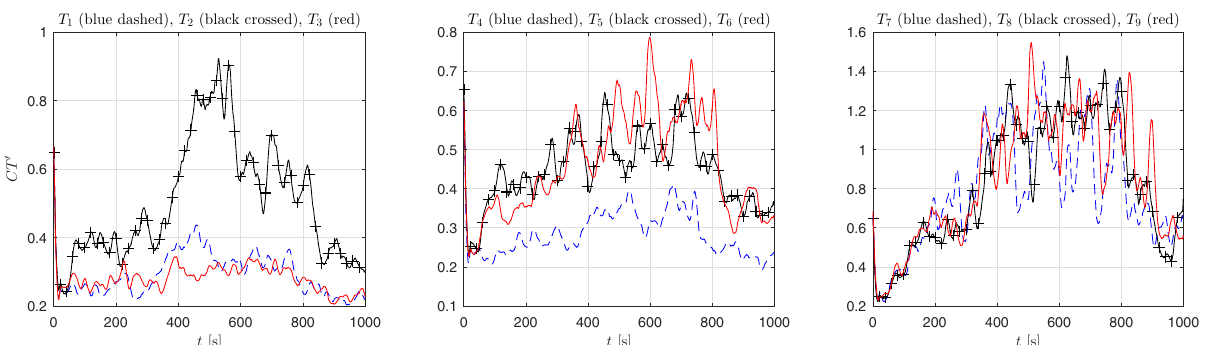
Figure 11. Excitation signals for the nine-turbine simulation case. The yaw angels are set to